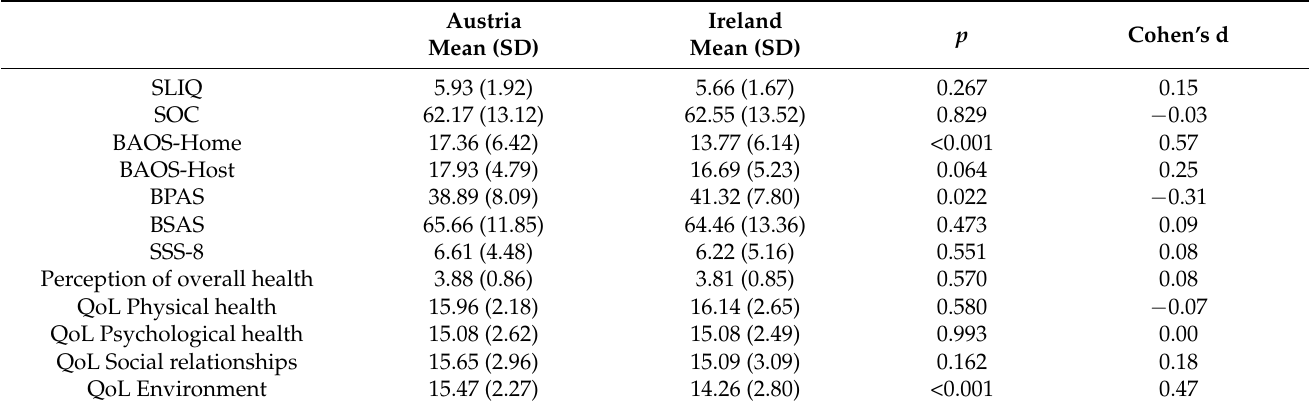
Table 5. Difference between Croats living in Austria and